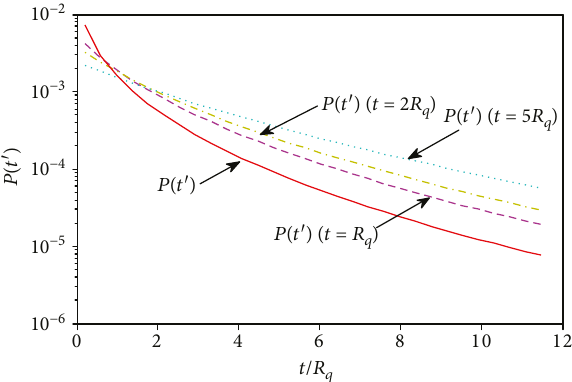
Figure 4: P t ′ is shown for t = R t = 0 which returns to P r distribution. At di ff erent elapsed time t , P t ′ exhibits varying degrees of slow